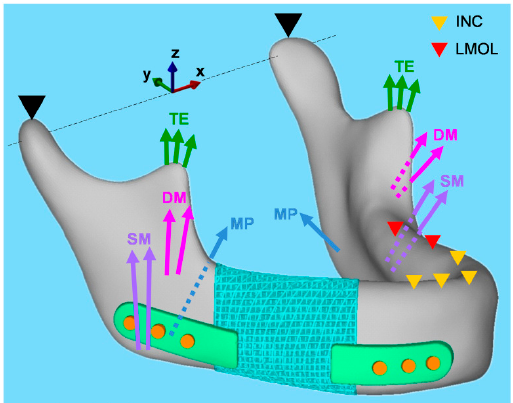
Figure 3. Muscular forces (arrow) and constraints (triangle) in the finite element model for simulation of the incisal clenching and left unilateral molar clenching tasks, respectively. SM, superficial masseter; DM, deep masseter; MP, medial pterygoid; TE, temporalis.